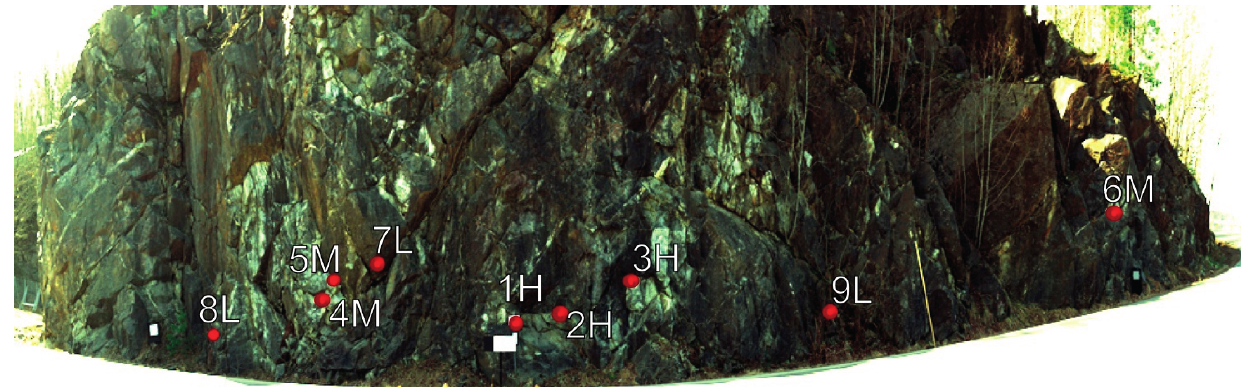
Figure 5. Sampling positions of the nine collected field samples. The letters within the descriptions of the sample locations represent the in situ interpretations of the relative sample enrichment (H-high, M-middle,